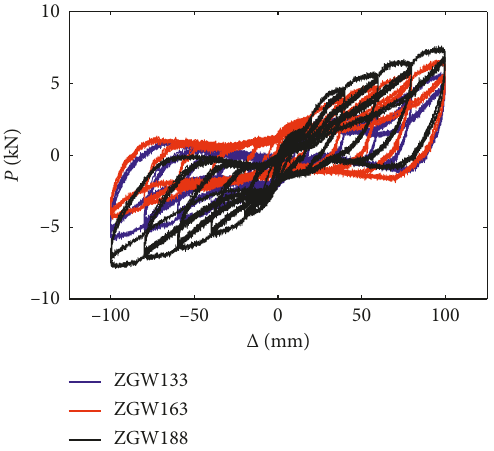
Figure 9: P - Δ hysteresis curve for unilateral column foot damage (ZJJ).